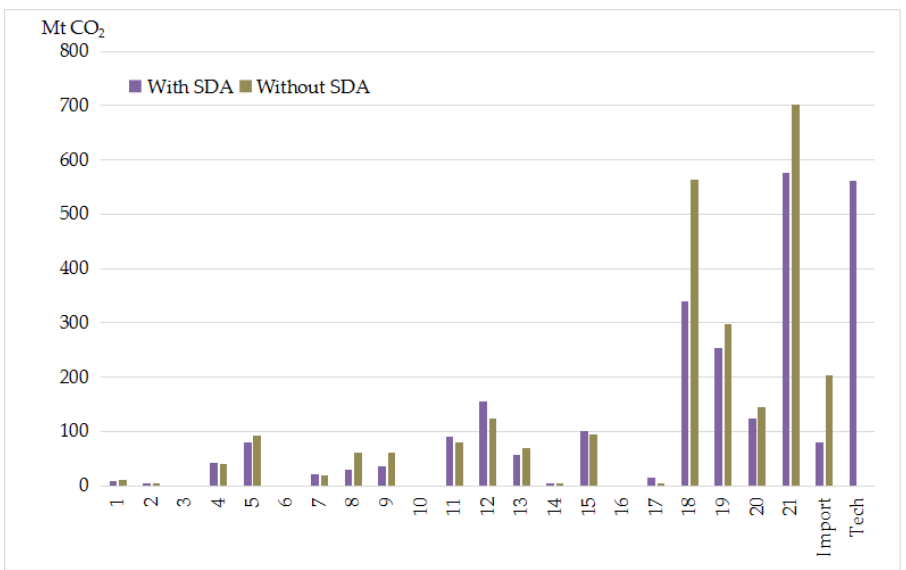
Figure 5. Comparing DHI/O modeling with and without SDA for estimating ERCE embodied in CSFAI.